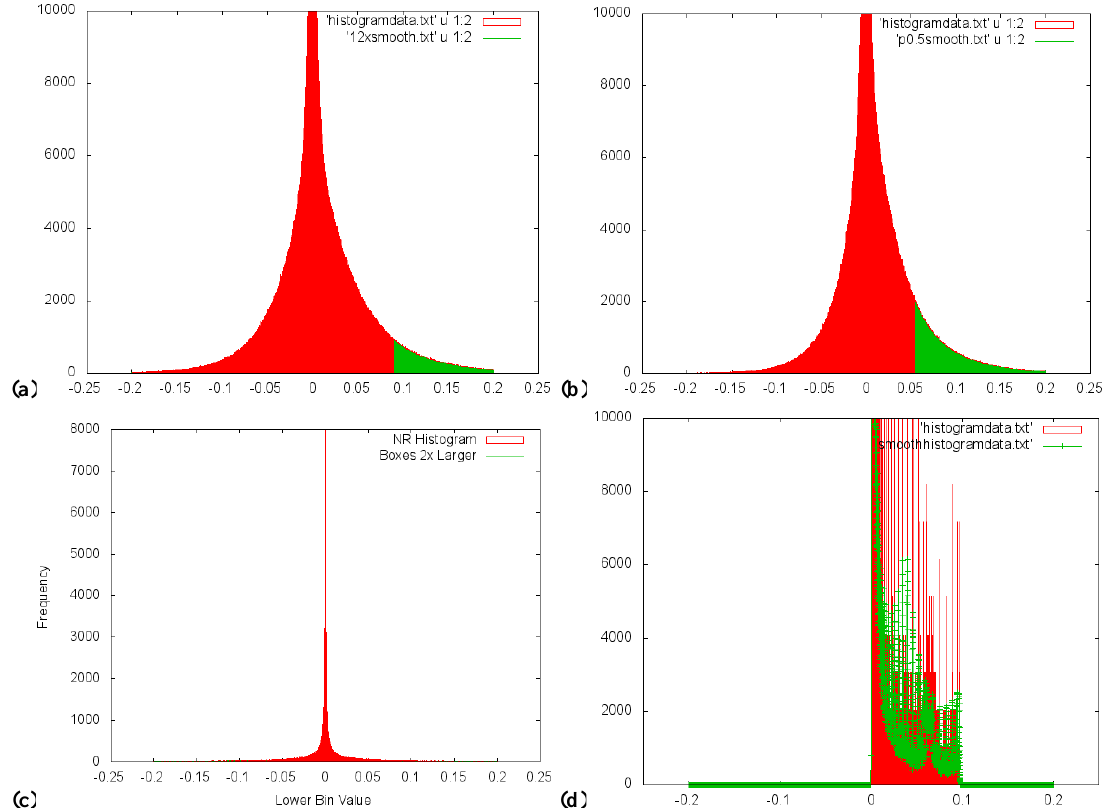
Fig. 2. These figures show histograms of the gradient of the reversing component of the large scale magnetic field in the direction normal to the unperturbed current sheet, i.e. ∂ y B x . (a) is for the highest power simulation, P = 1. (b) is for P = 0 . 5. (c) is for P = 1 but with no large scale magnetic field reversal, i.e. simply locally driven strong turbulence. Bins with twice the number of cells as the corresponding bin with the opposite sign of ∂ y B x are shown in green. (d) shows the first simulation in the absence of turbulent